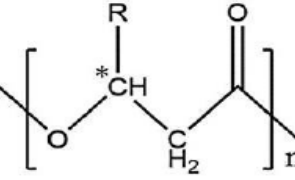
Figure 1. General structure of poly(3-hydroxyalkanoate). * means assymetric